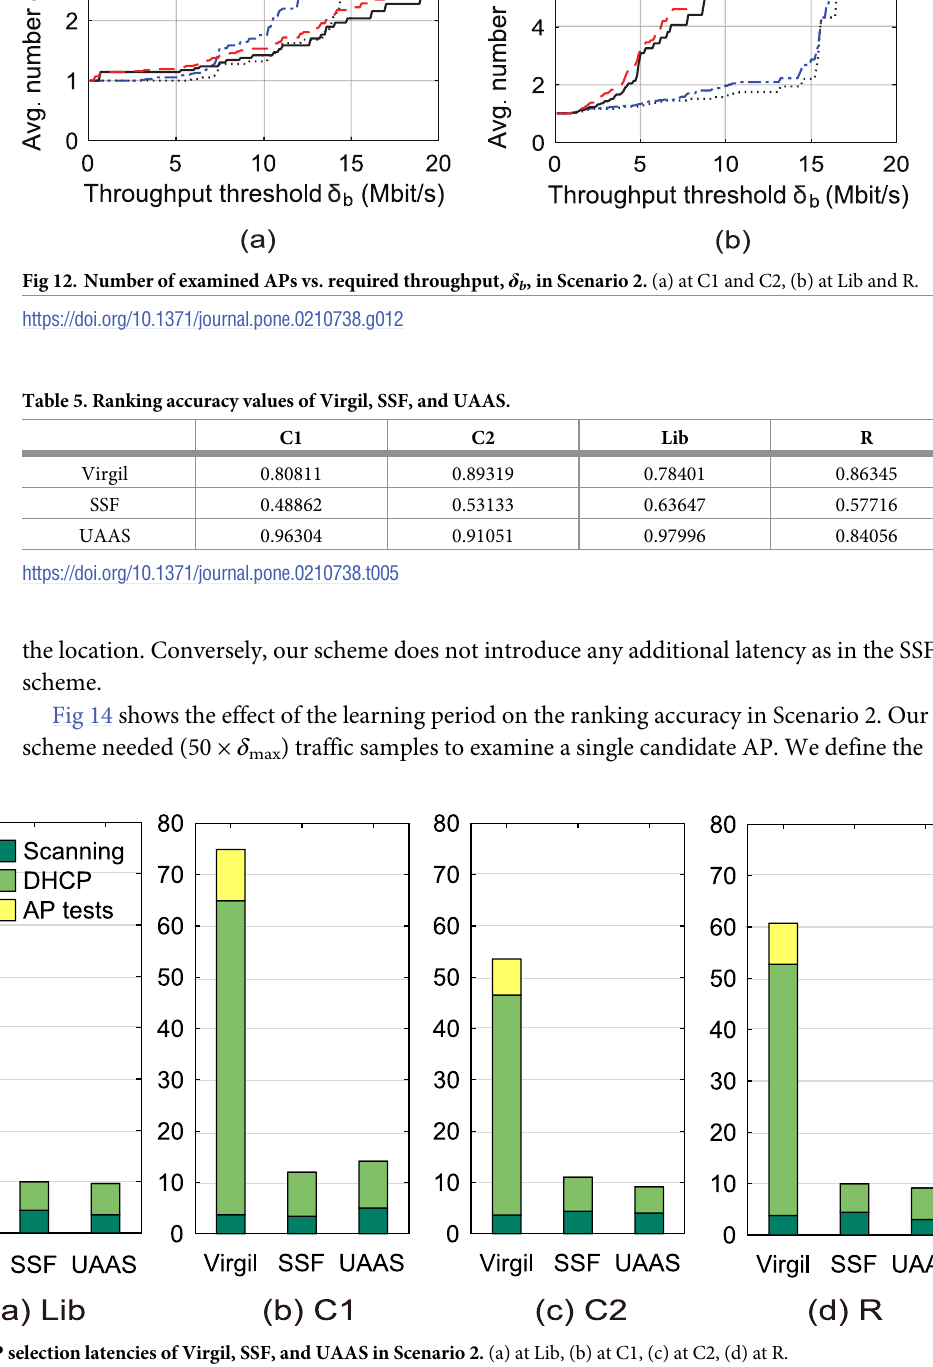
, in Scenario 2. (a) at C1 and C2, (b) at Lib and R. b